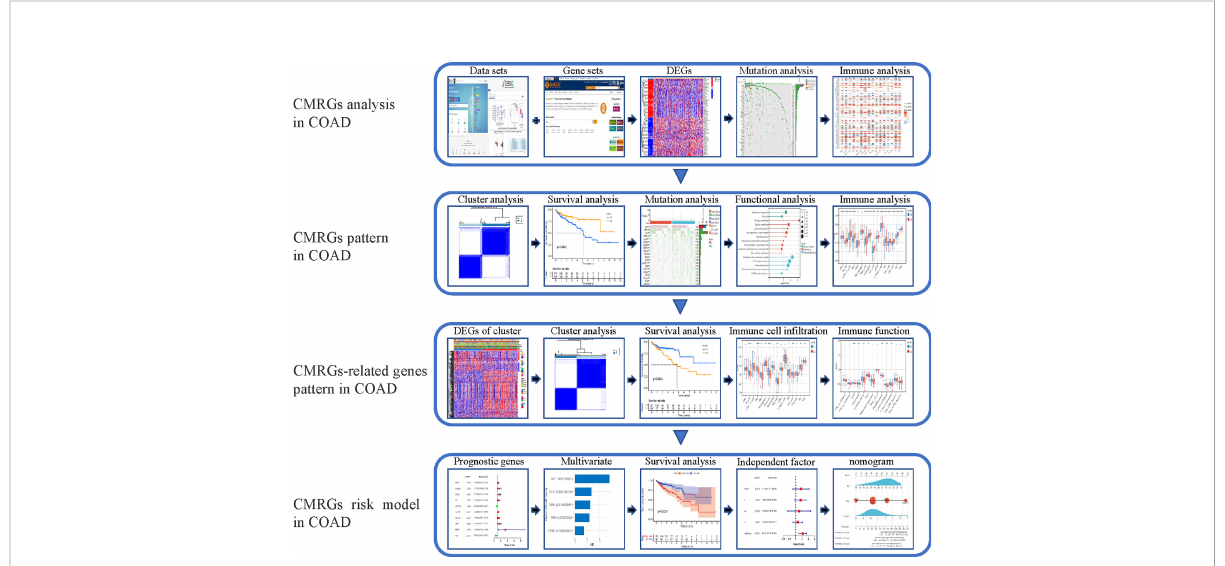
FIGURE 1 The work fl ow of research. CMRGs, Copper metabolization-related genes; COAD, Copper metabolization-related genes; DEG, differentially expressed